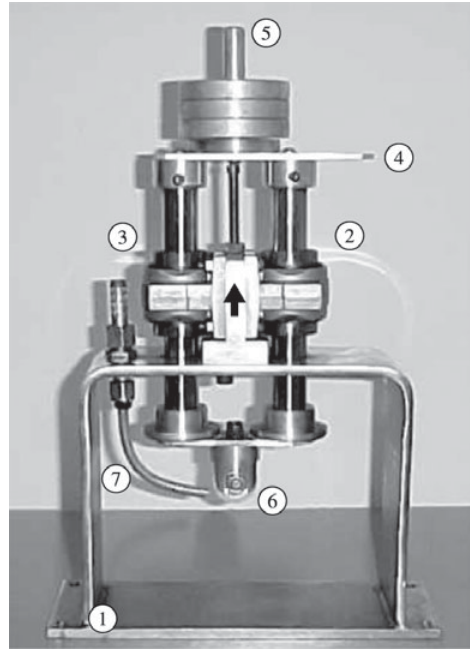
Figura 1. Banco de ensaios mostrado em detalhes. Elementos: base (1), dispositivo-guia (2), hastes cilíndricas (3), trave para registro de deslocamento (4), haste cilíndrica central (5), suporte do disco estático (6) e mangueira